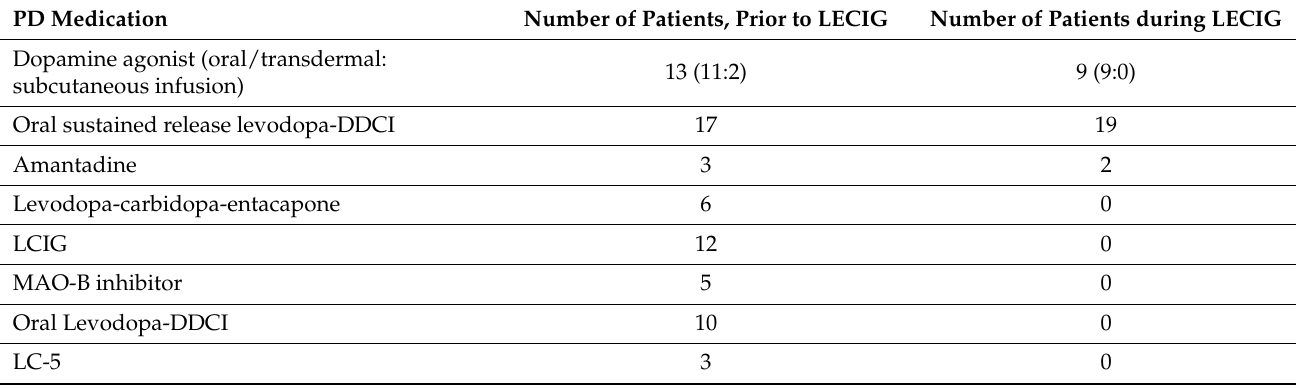
Table 3. Treatments with other dopaminergic Parkinson’s disease (PD) medications prior to and during LECIG therapy. PD Medication Number of Patients, Prior to LECIG